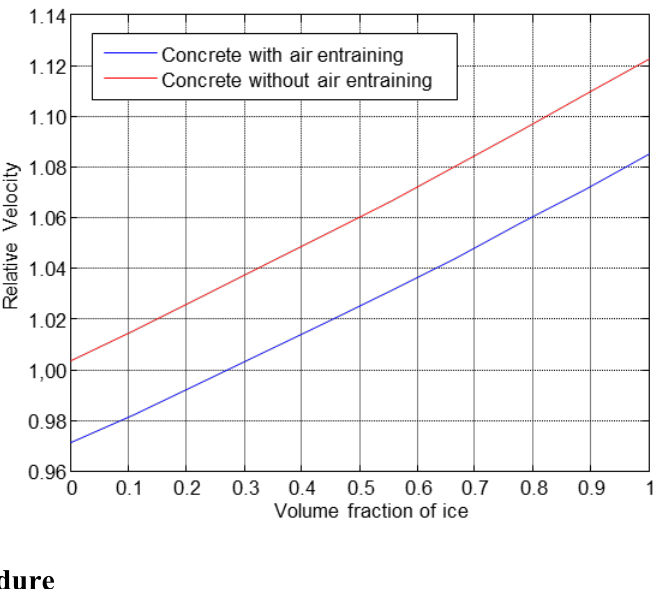
Figure 3. Theoretical study of the behaviour of the ultrasonic velocity versus ice volume.